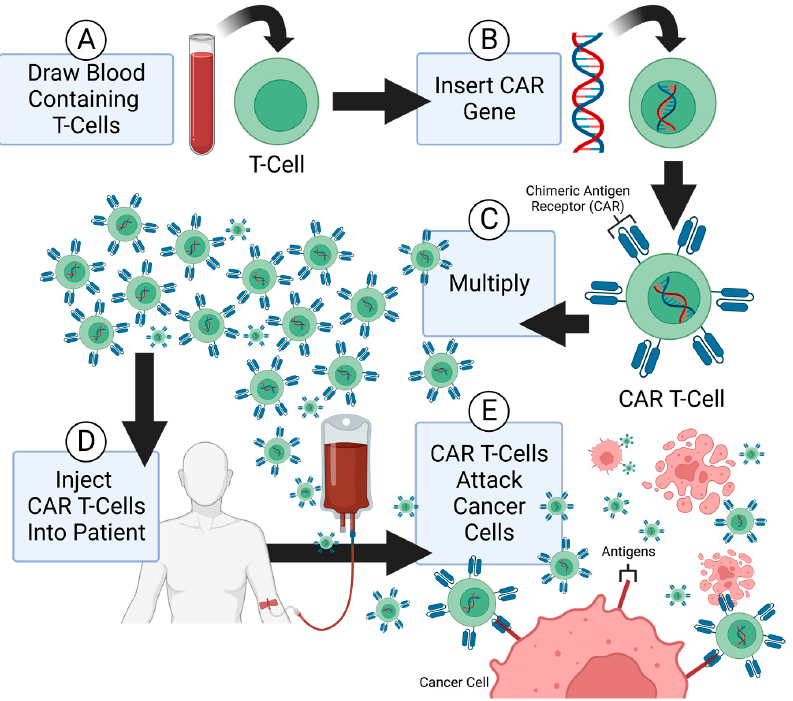
Figure 2. Overview of chimeric antigen receptor (CAR) T-cell therapy. ( A ) Initial steps include obtainment of T cells from a blood sample, followed by ( B ) insertion of CAR genes into T cells with subsequent expression of CAR on the T-cell membrane surface. Next, ( C ) T-cell multiplication is induced, followed by ( D ) insertion of the CAR T cells into the patient. ( E ) CAR T cells then bind to specific antigens located on the membrane surface of cancer cells and induce an immune response.